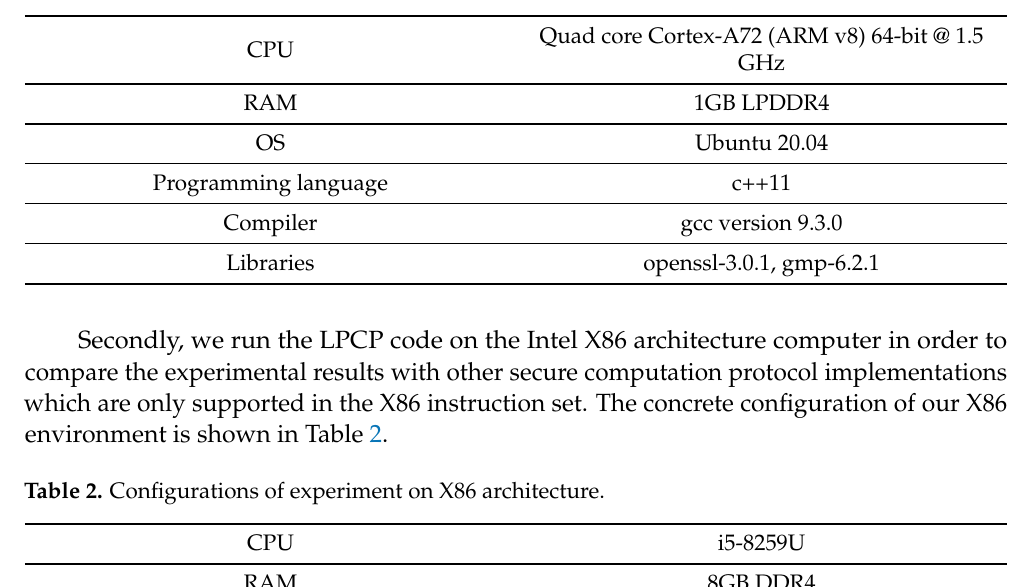
Table 1. Configurations of experiment on ARM architecture.